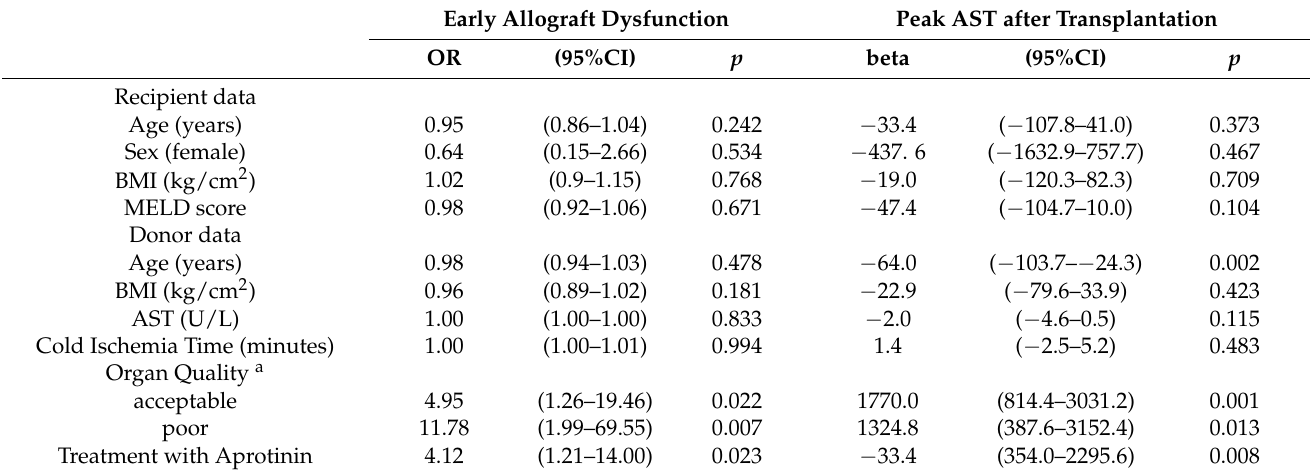
Table 4. Intraoperative treatment with aprotinin is associated with early allograft dysfunction (EAD) and peak aspartate transaminase (AST) after liver graft transplantation. Two multivariable models in a cohort of 84 liver graft recipients (42 treated with aprotinin and 42 propensity score matched controls) describe this association. On the left, a binary logistic regression model for EAD and on the right a linear regression model for peak AST.